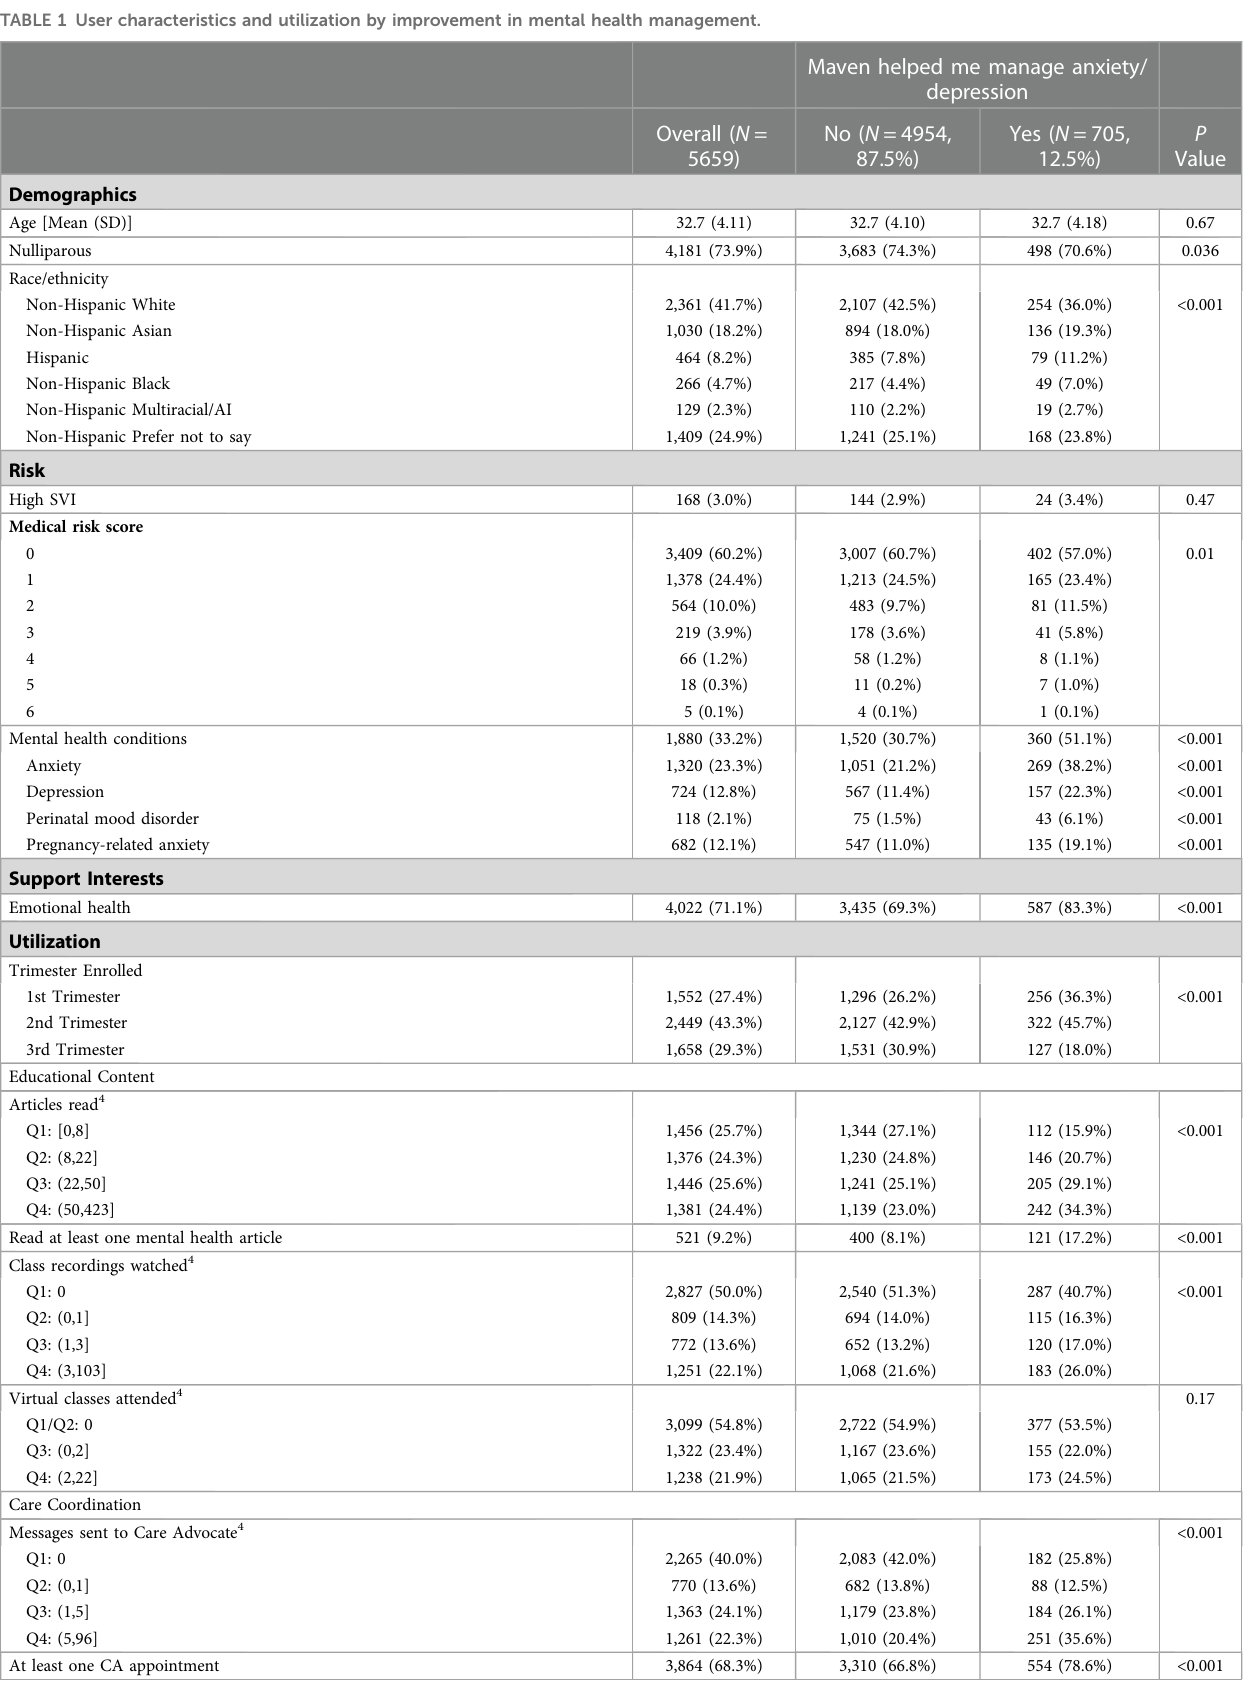
TABLE 1 User characteristics and utilization by improvement in mental health